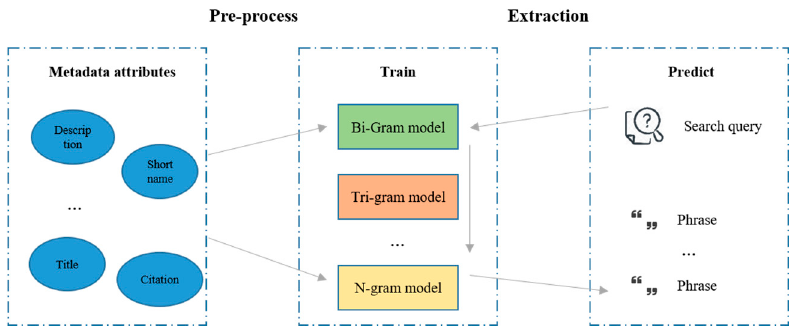
Figure 4. Workflow of -concept recognition.